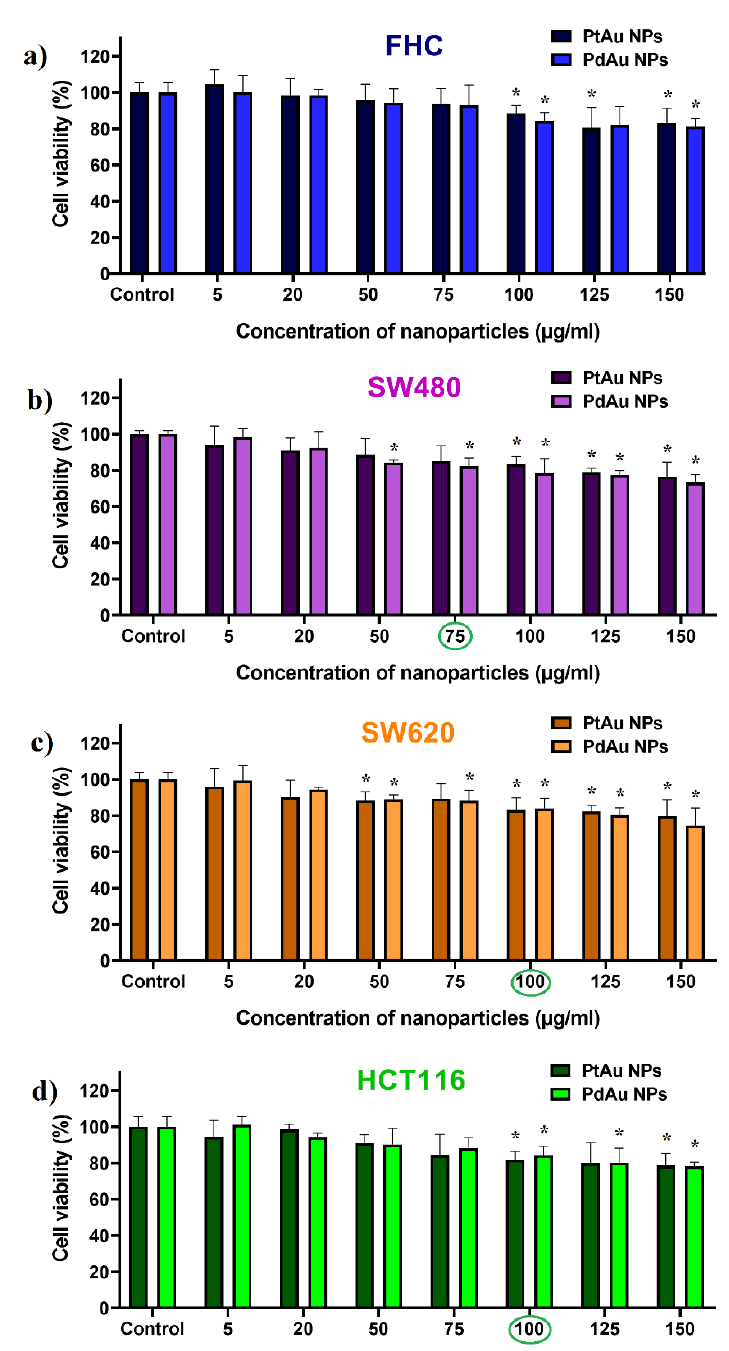
Figure 6. Cytotoxicity of PtAu and PdAu NPs against ( a ) FHC, ( b ) SW480, ( c ) SW620, and ( d ) HCT116 cells after 18 h of incubation. Data were considered significant when * p < 0.05 vs. control. The concentration of PtAu and PdAu NPs considered optimal are marked in green.